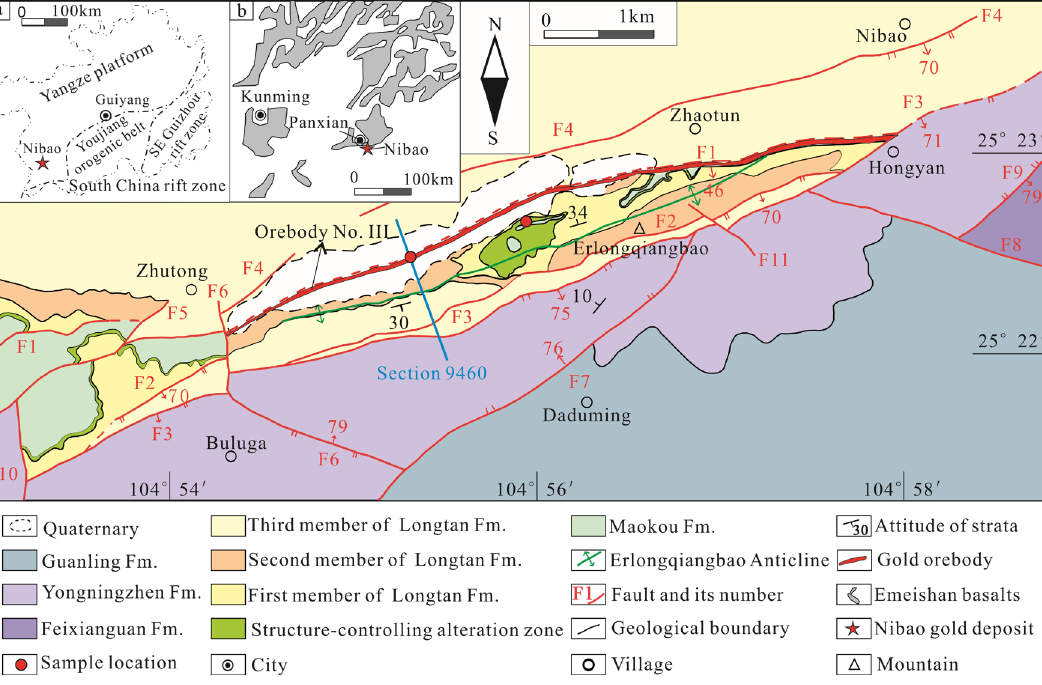
Figure 2. Geological map of Nibao gold deposit: ( a ) tectonic map and ( b ) geological map of the Emeishan basalt distribution (modified from He et al. [20]).